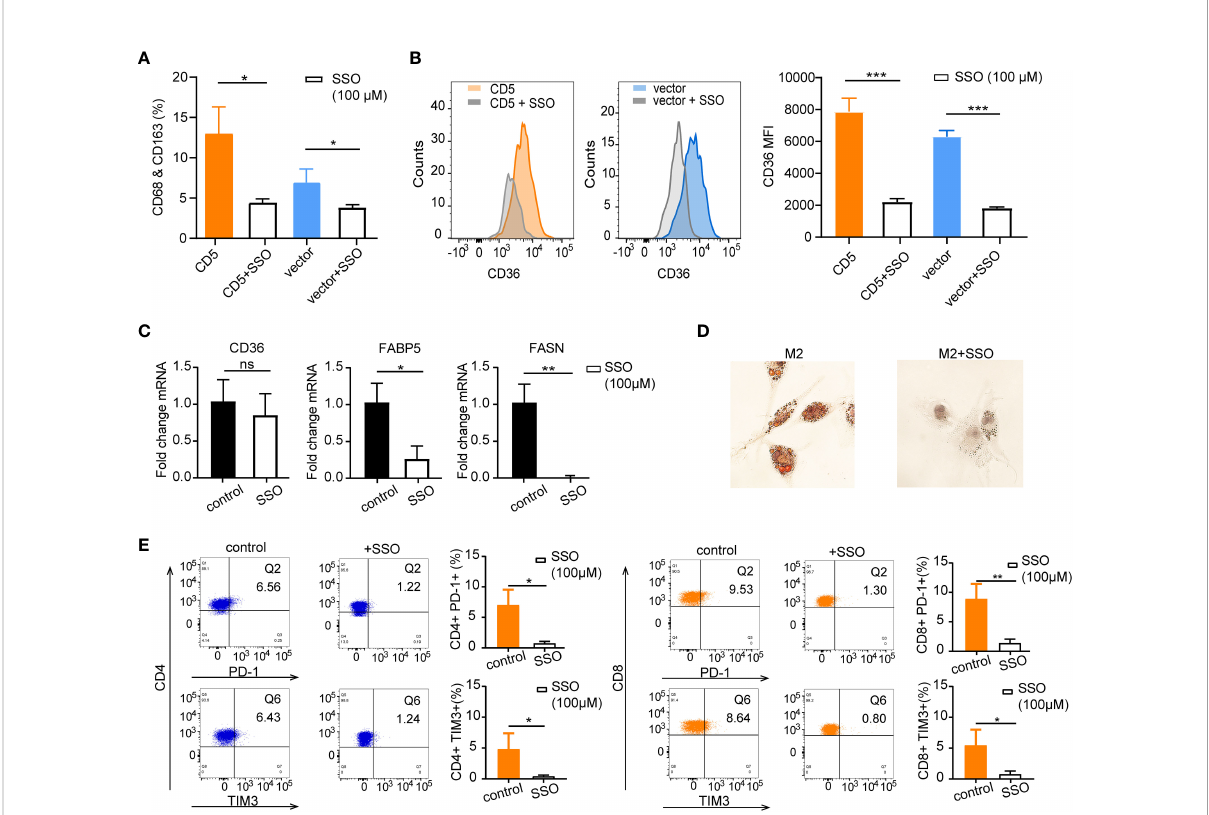
FIGURE 6 The therapeutic impacts of sulfosuccinimidyl oleate (SSO) on M2 lipid metabolism and CD36 expression. (A) Bar plot of M2 proportion in PBMC cocultured with LY-10/CD5 or LY-10/vector with or without 100 m M SSO treatment for 72 h, summarized as mean ± SD (n = 3). (B) Flow cytometry analysis of CD36 expression on M2 macrophages comparing the counts and median fl uorescence intensity (MFI) of CD36 on M2 in PBMC cocultured with LY-10/CD5 or LY-10/vector with or without 100 m M SSO treatment. (C) The normalized mRNA expression of CD36, FABP5, and FASN in THP-1 – induced M2 cells with or without 100 m M SSO treatment. (D) Oil red O staining of lipid droplets in THP-1 – induced M2 cells with or without 100 m M SSO treatment. (E) Expression of immune checkpoint PD-1 and TIM3 on CD4 and CD8 T cells after LY-10/CD5 cocultured with PBMC with or without 100 m M metformin treatment for 72 h. * represented signi fi cant difference of P<0.05; ** represented signi fi cant difference of P<0.01; *** represented signi fi cant difference of P<0.001. ns, no signi fi